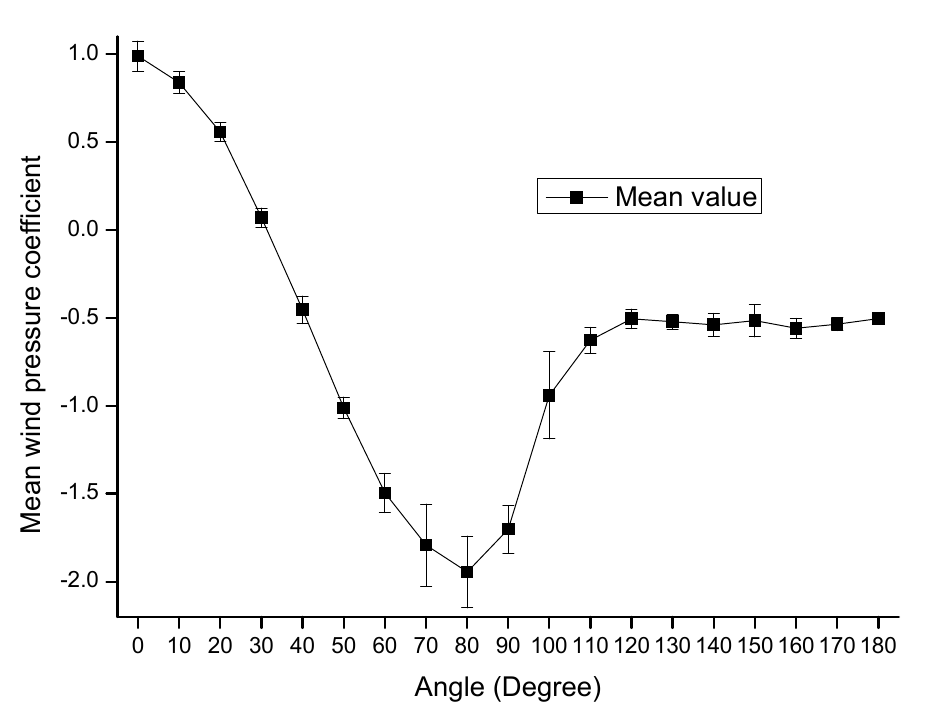
Figure 5. Mean wind pressure distributions around the cooling tower model at different turbulence intensities.